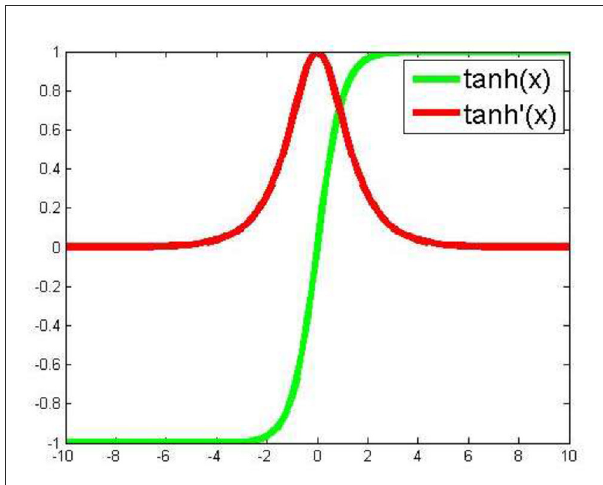
FIGURE1 Activation function based on the Tanh function tanh(x) and its derivative